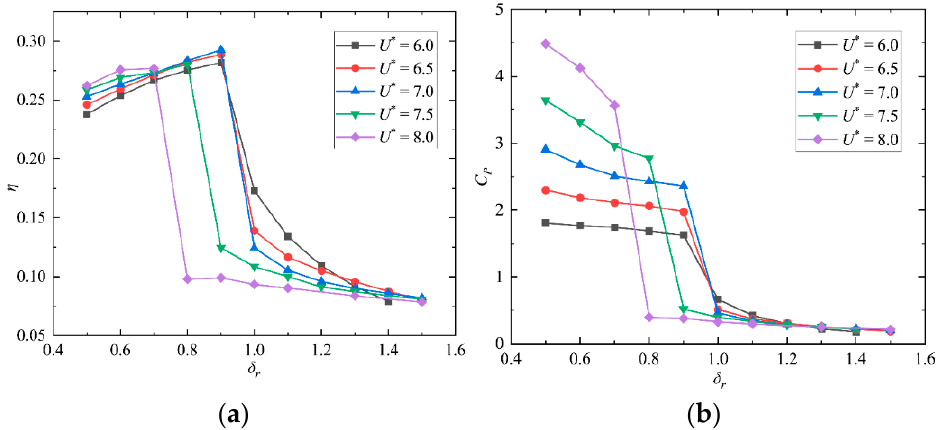
Figure 13. Variations of energy harvesting efficiency and power coefficient of the bent plate with